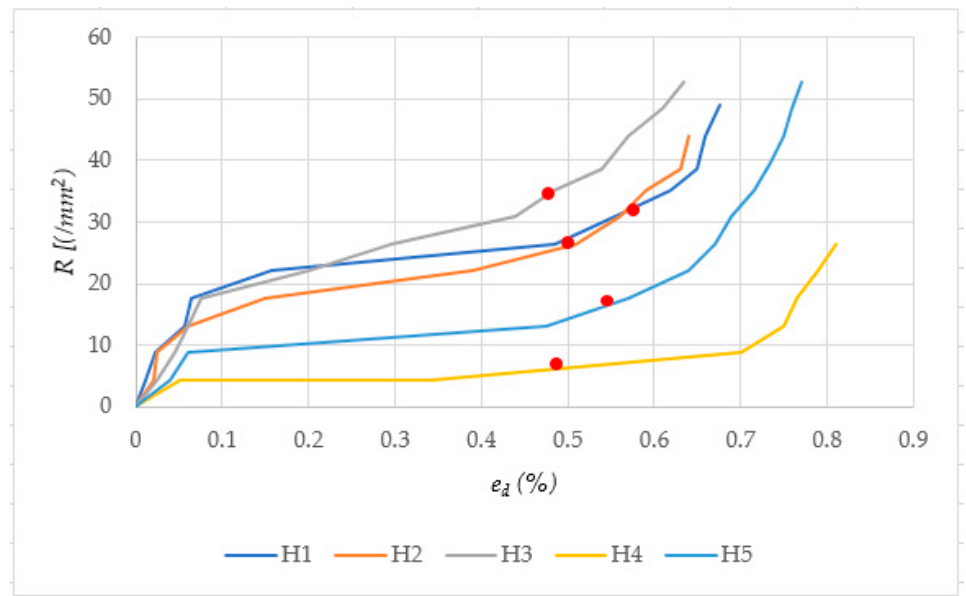
Figure 7. Stress–strain curves for samples reinforced with steel wire element.